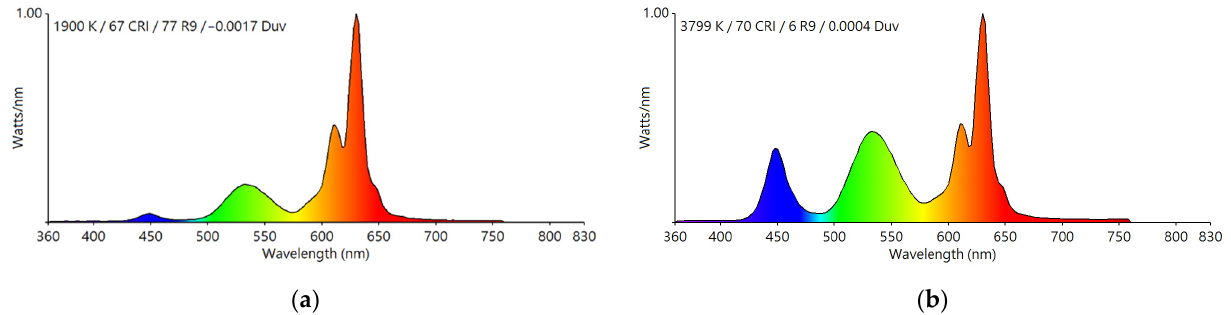
Figure 12. Sleeping light spectrum generated by smart mobile devices ( a ) 1900 K correlated color temperature spectrum ( b ) 3800 K correlated color temperature spectrum.